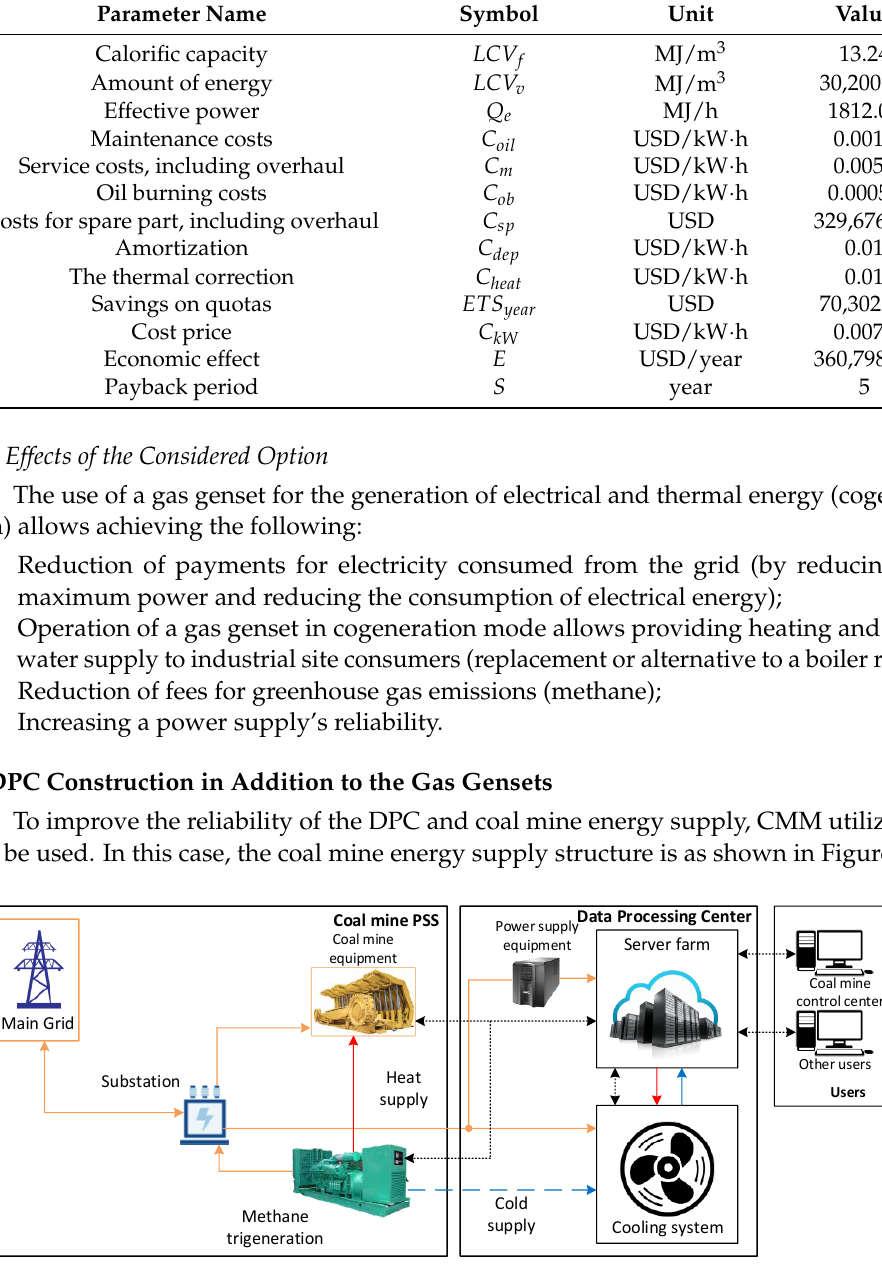
Figure 6. Structure of power supply system of coal mine and